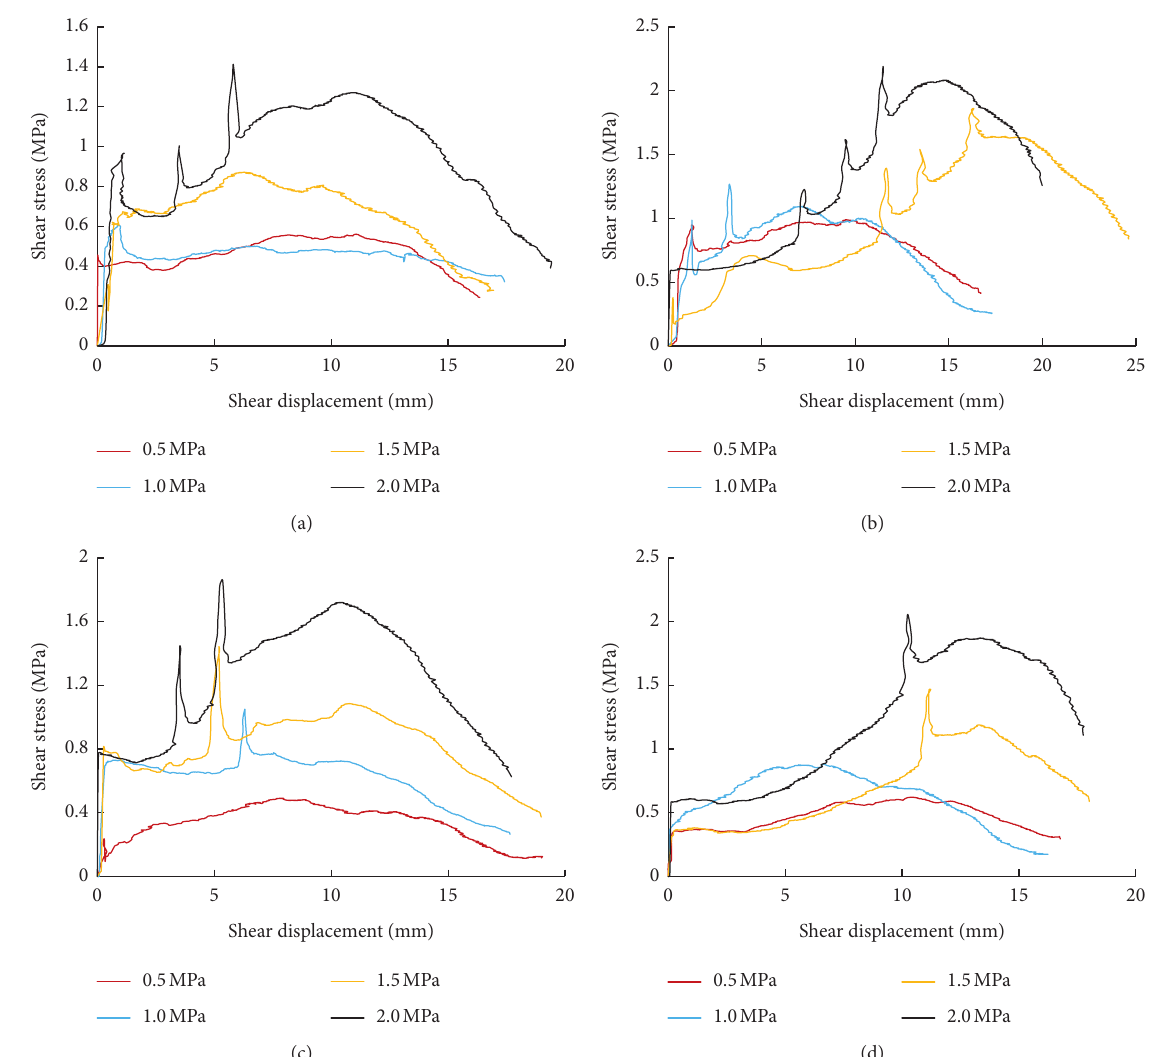
Figure 9: Shear stress-shear displacement curves of different normal stress joints with an opening degree of 13 mm. (a) Specimen 1#. (b) Specimen 2#. (c) Specimen 3#. (d) Specimen